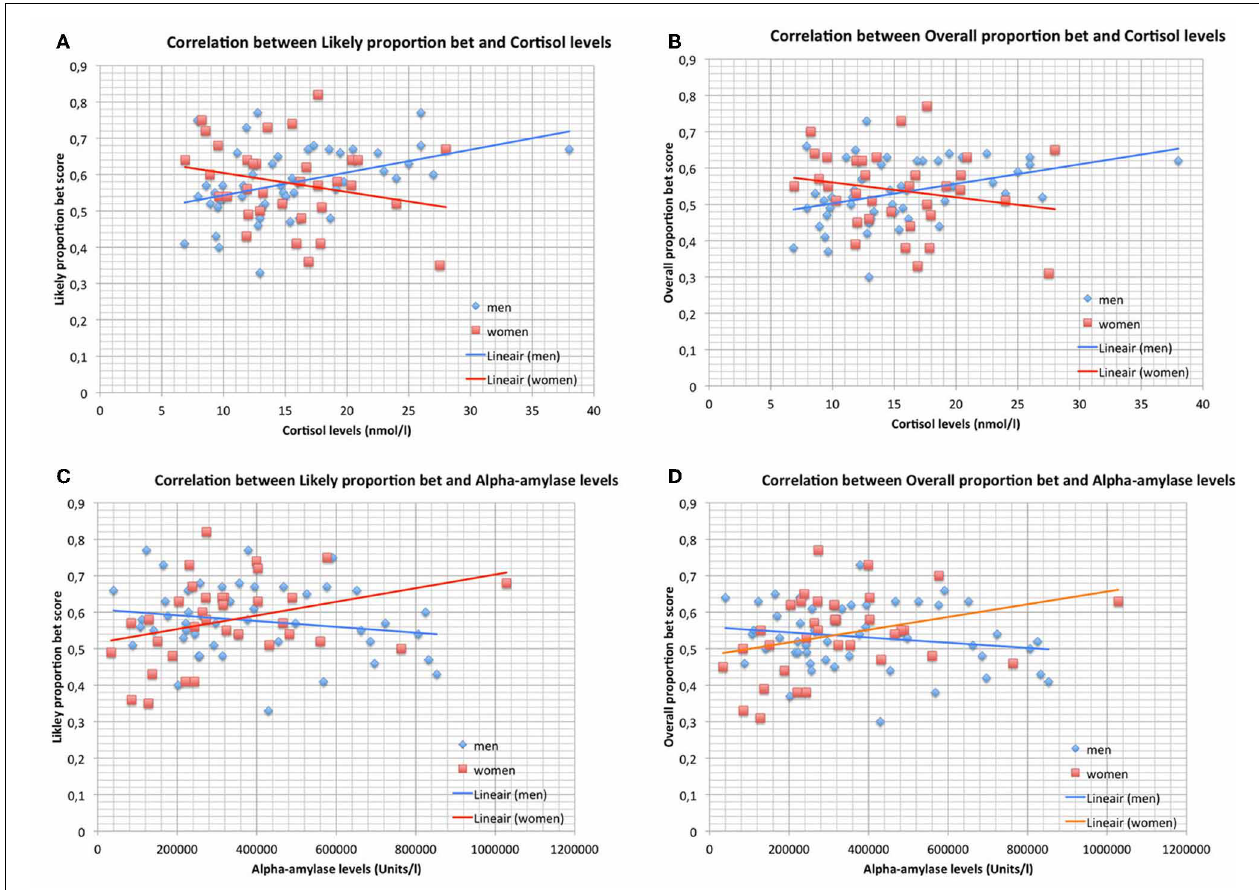
FIGURE 2 | (A) Correlation between Likely proportion bet and cortisol levels during the CGT in men ( n = 49) and women ( n = 34). Trend-lines are added to indicate correlations. (B) Correlation between Overall proportion bet and cortisol levels during the CGT in men ( n = 49) and women ( n = 34). Trend-lines are added to indicate correlations. (C) Correlation between Likely